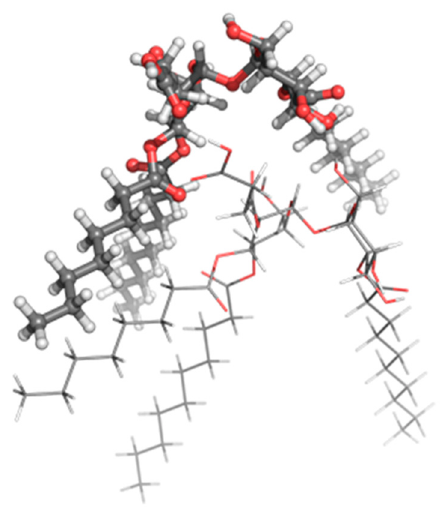
Figure 5. Two (neutral) molecules of TL are shown to depict possible molecular interactions between them. One molecule is presented with sticks for the sake of simplicity.